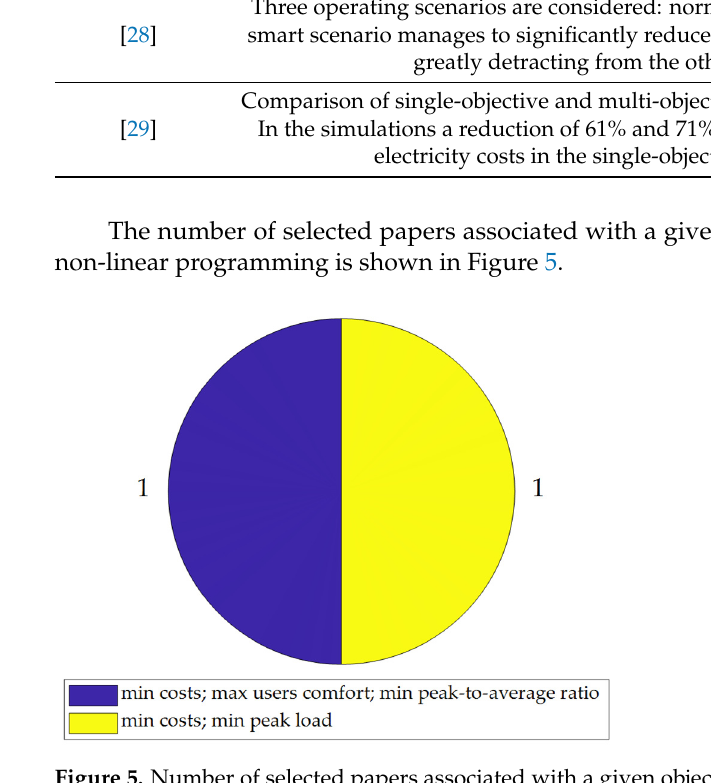
Figure 5. Number of selected papers associated with a given objective for mixed-integer non-linear programming.